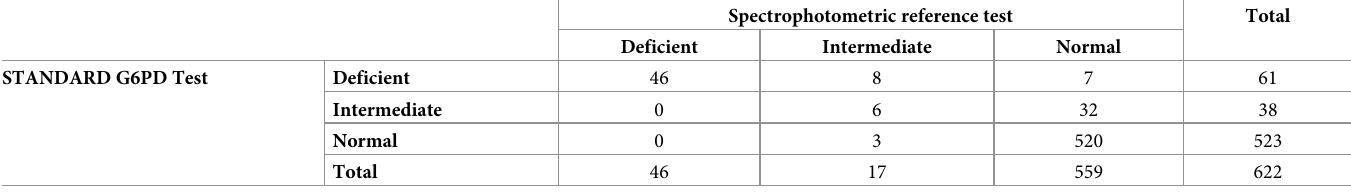
Table 6. Percent agreement between the STANDARD G6PD Test and the spectrophotometric reference test using the manufacturer’s threshold values at 30% and 70% G6PD activity thresholds, on capillary